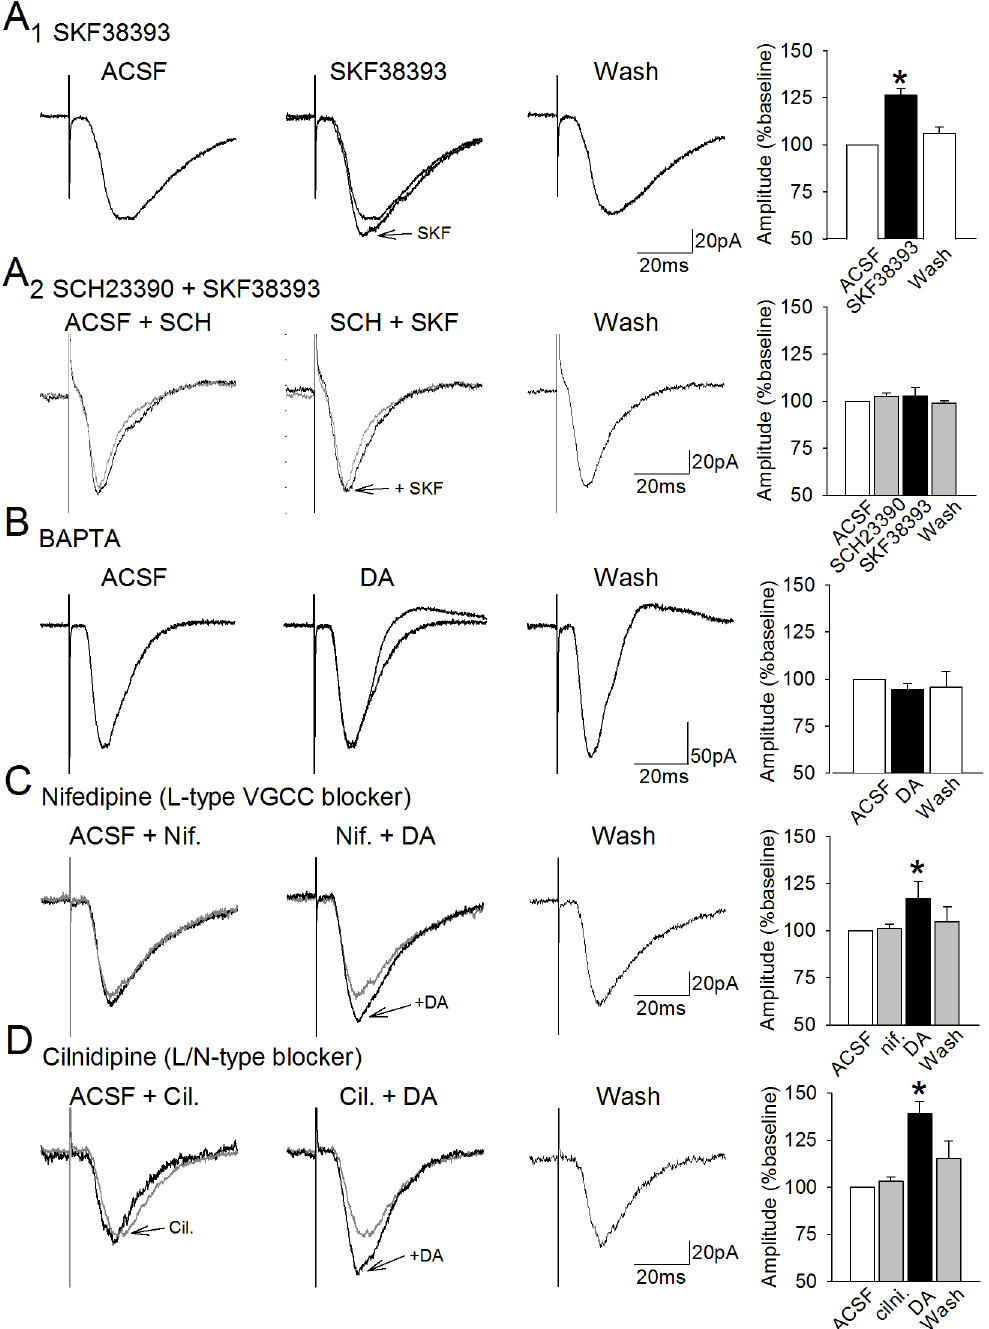
Fig 1. Dopaminergic facilitation of EPSCs is dependent on intracellular calcium, but not L- or N-type VGCCs. A. Bath application of the dopamine D 1 - receptor agonist SKF38393 (10 μ M) induces a reversible facilitation of the amplitudes of glutamate-mediated excitatory postsynaptic currents in layer II lateral entorhinal cortex neurons (A 1 ). Traces show averaged EPSCs for a neuron before, during, and after 5-min application of SKF38893. The histogram at right shows mean EPSC amplitudes for the group of cells. Bars indicate ± one SEM and the asterisk indicates p < 0.05. In addition, the facilitation induced by SKF38393 is blocked in the presence of the D 1 receptor blocker SCH23990 (A 2 ). B. Amplitudes of EPSCs recorded from cells filled with the Ca 2+ chelator BAPTA (10 μ M) remained stable during dopamine (DA) application. C,D. Bath-application of the L-type voltage-gated calcium channel (VGCC) blocker nifedipine (10 μ M; C) or of the L/N-type VGCC channel blocker cilnidipine (10 μ M; D) failed to block the dopaminergic facilitation of EPSCs ( * , p < 0.001). Traces for the baseline and VGCC blockers are superimposed.